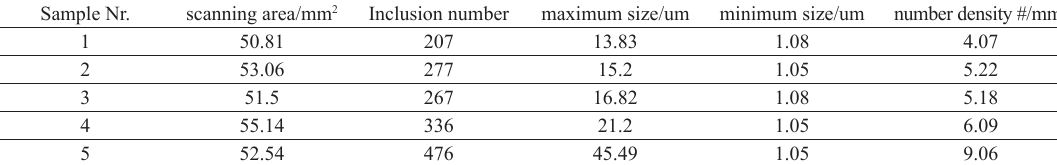
Table 5. Inclusion analysis of the samples 1 to 5 with INCASteel automatic inclusion analyzer. Sample Nr.